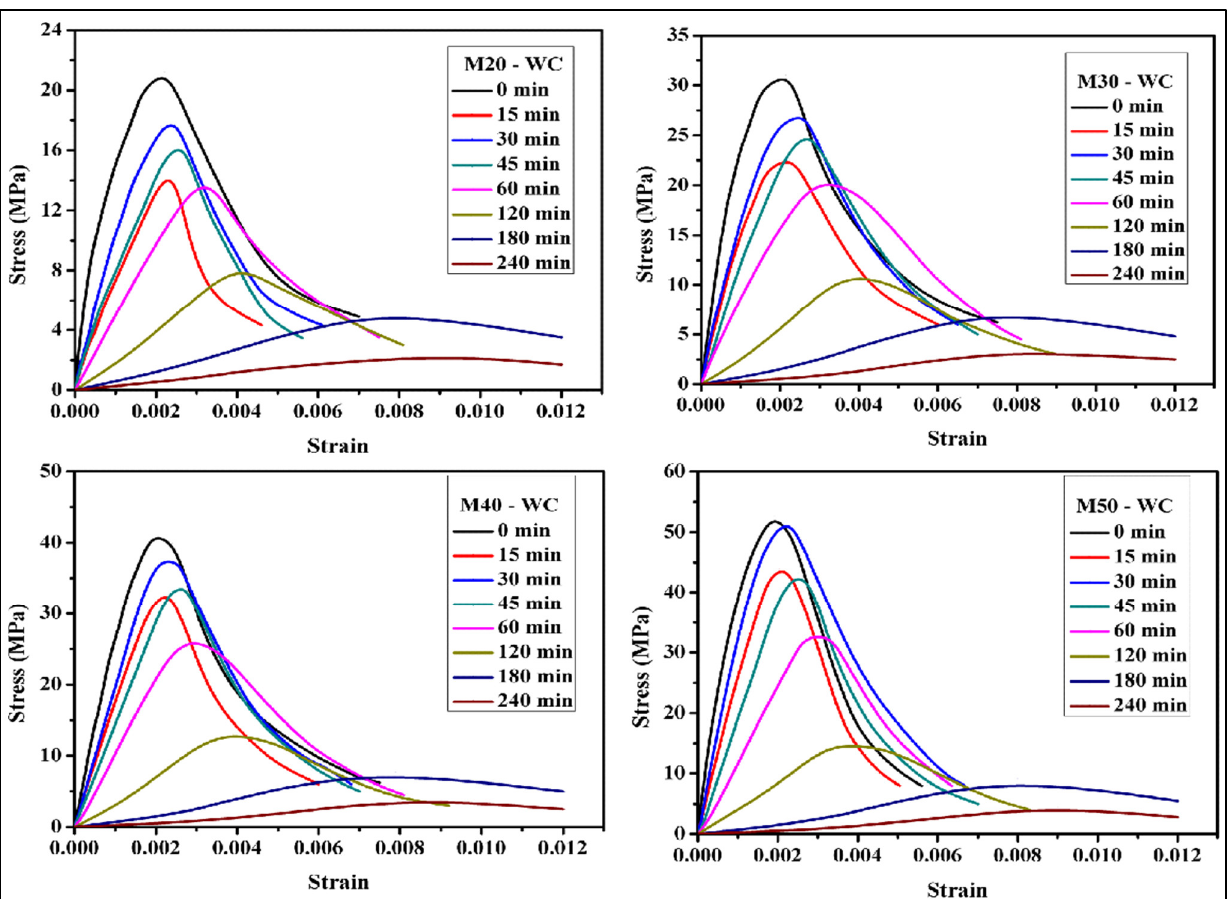
Figure 4. Stress–strain behavior of water-cooled specimens.